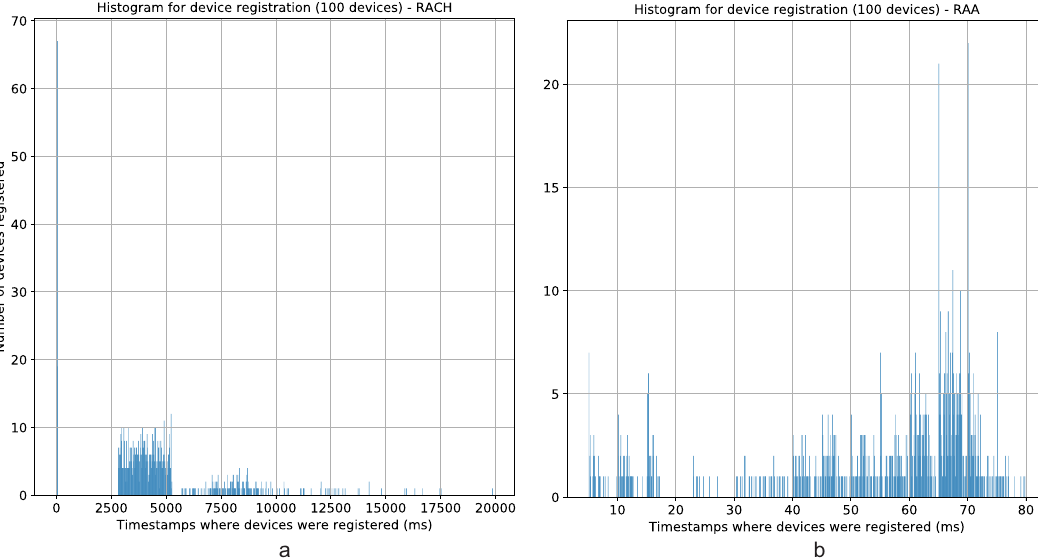
Figure 9. Number of devices registered per time unit for the ( a ) classic Random-Access procedure and the ( b ) RAA